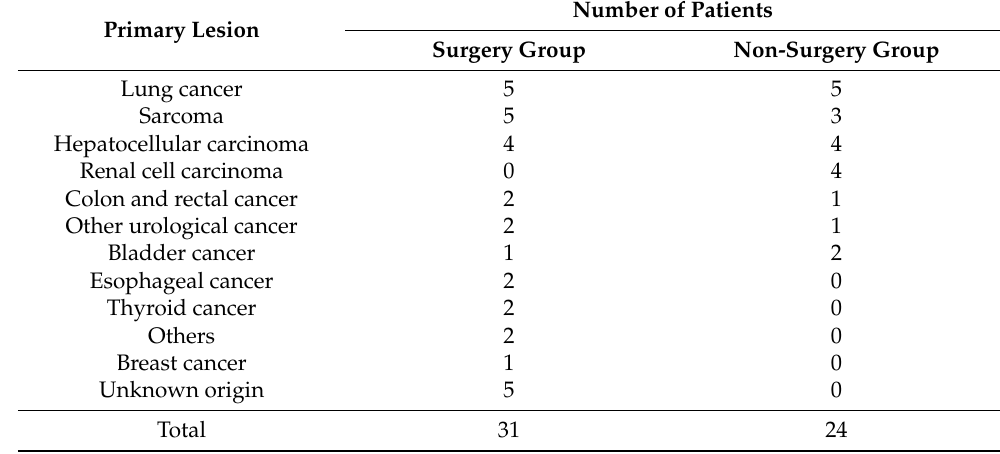
Table 2. Type of primary